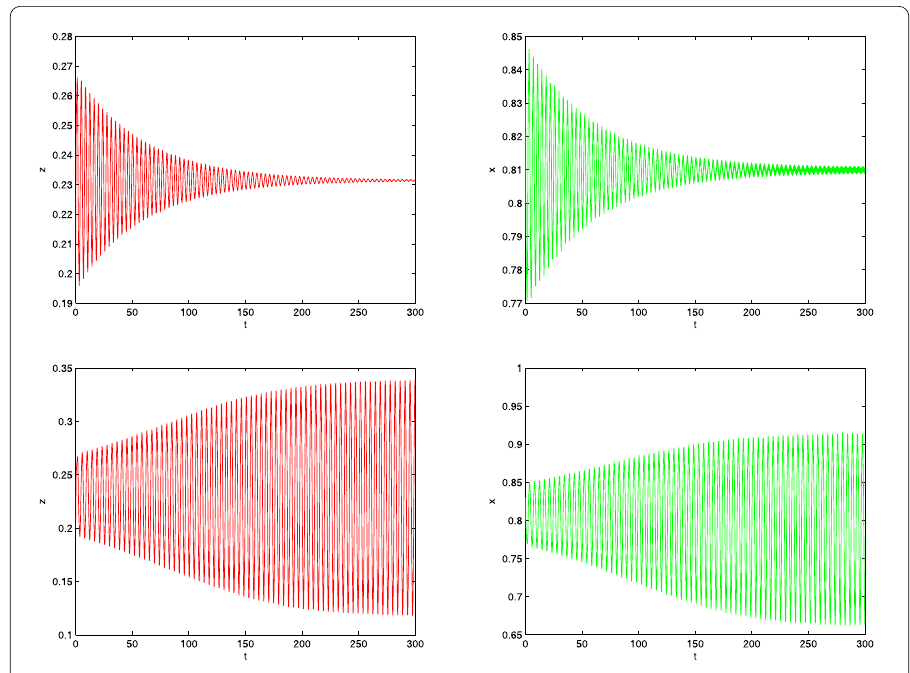
Figure 5 Waveform diagram for variable of x , z . The first two figures show that when τ = 1.50 < τ 10 , the system is stable around the equilibrium point. When τ = 1.80 > τ 10 , the next two figures show that the system is unstable around the equilibrium